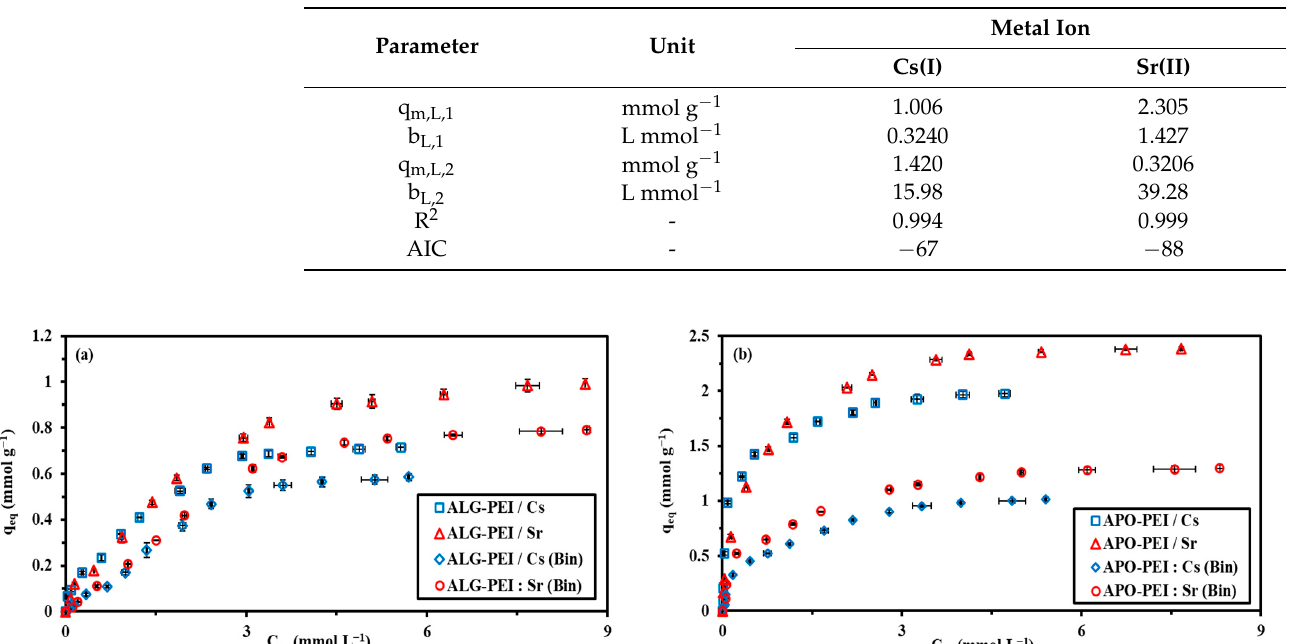
Table A4. Parameters for the modeling of Cs(I) and Sr(II) sorption isotherms (onto APO-PEI sorbent) using the LDS equation.